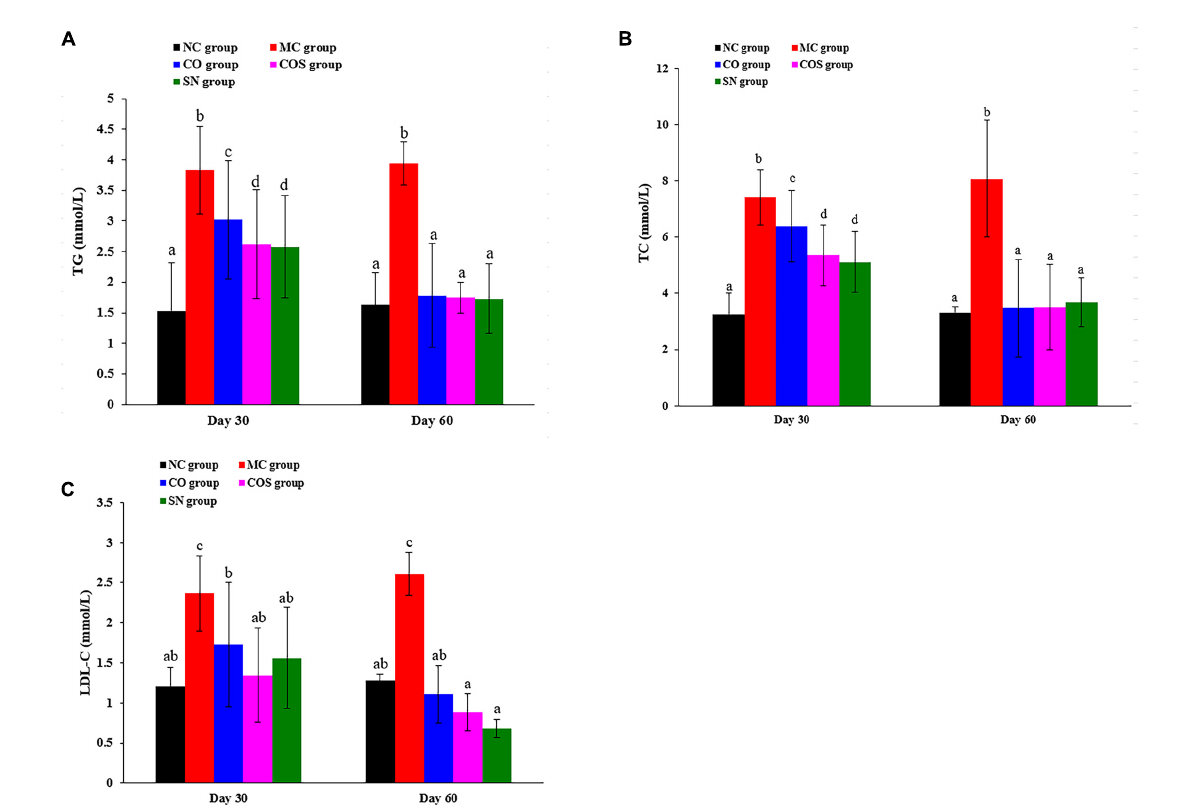
FIGURE2 After the end of modeling, serum lipid levels of hyperlipidemia-induced reproductive damage rats at the another 30th and 60th day by feeding test substance: (A) TG, (B) TC, and (C) LDL-C levels. TG, triglyceride; TC, total cholesterol; LDL-C, low-density lipoprotein cholesterol; NC, normal control; MC, model control; CO, Camellia oil; COS, Camellia oil + squalene; SN, sildenafil. All values are expressed as mean ± SD. Different letters represent significant differences ( p <